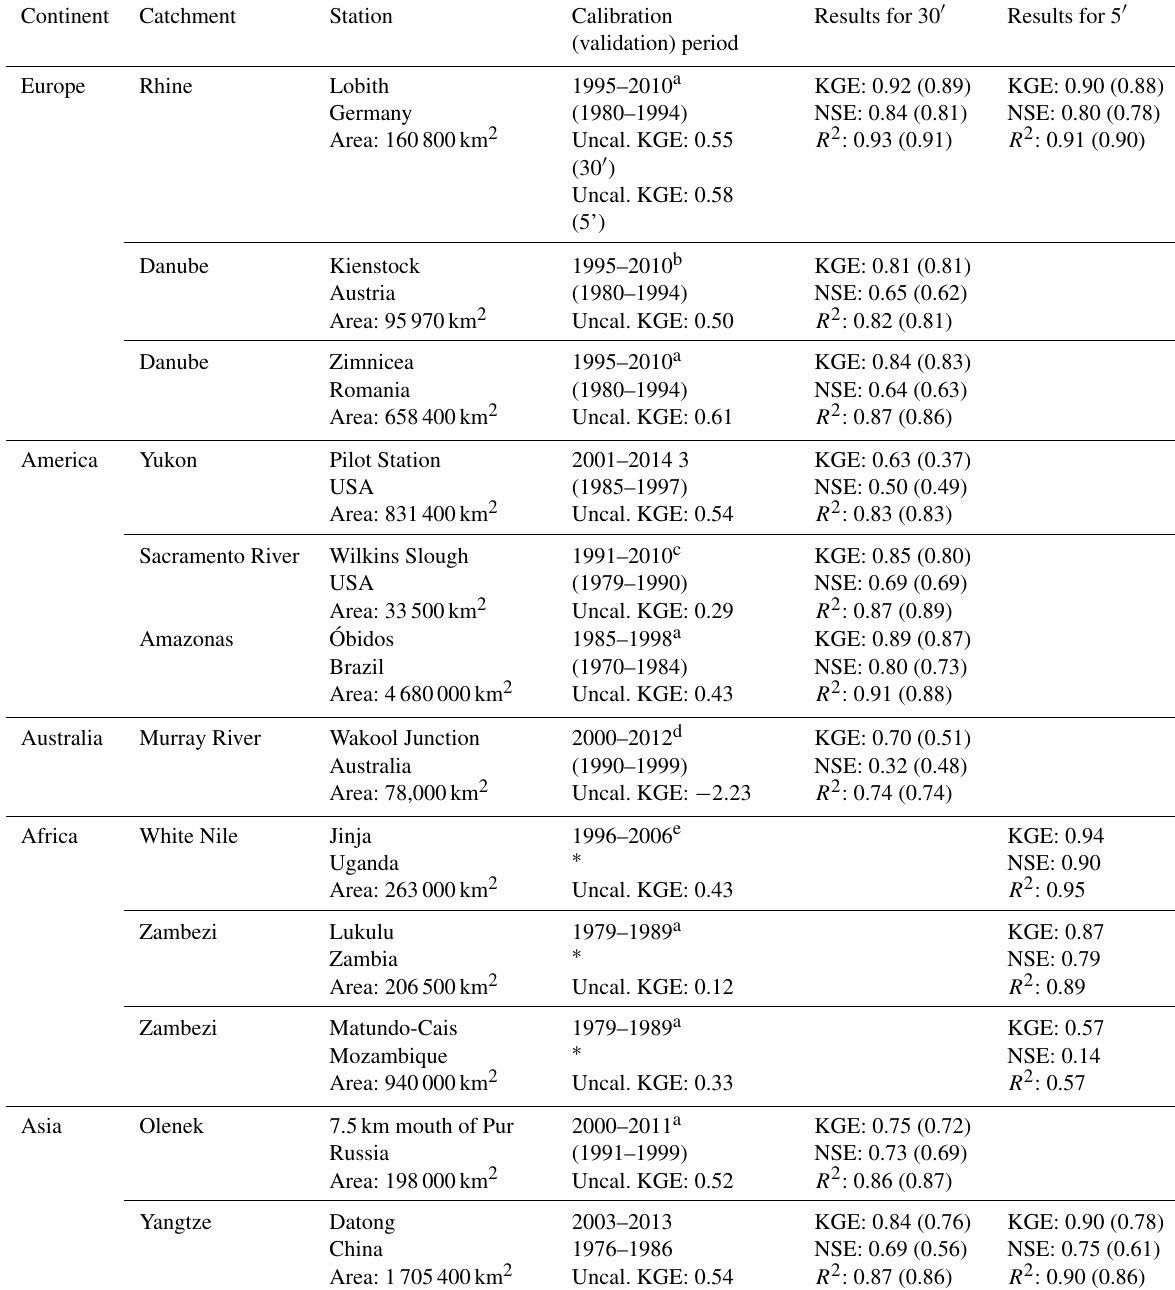
Table 7. Calibration results for some catchments worldwide.